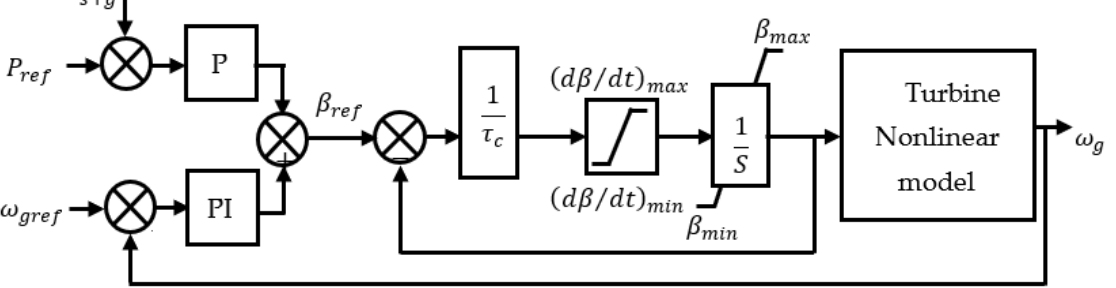
Figure 8. Angle of inclination regulator with model of pitch activation.